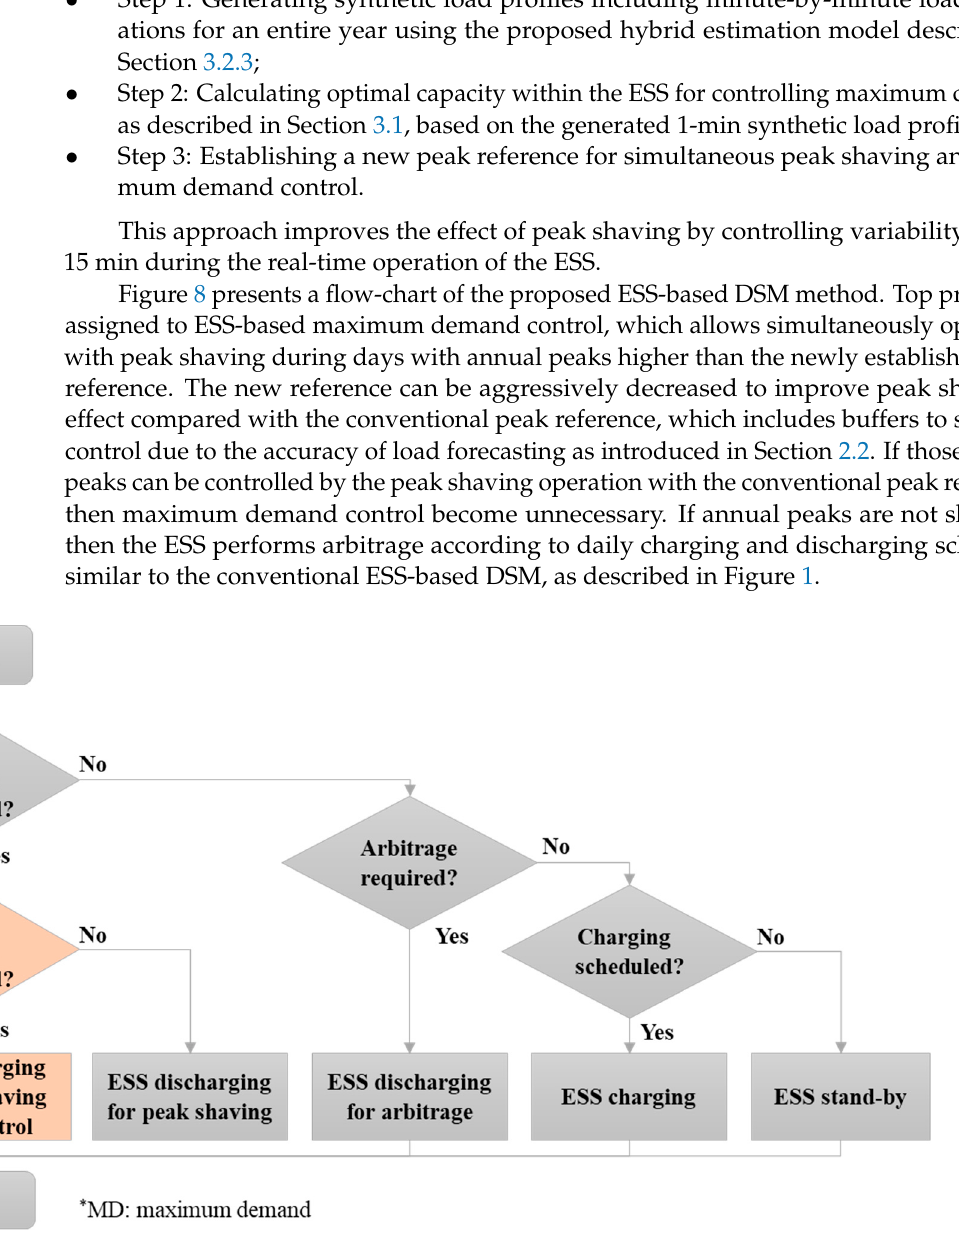
Figure 8. Flowchart of the proposed ESS-based DSM algorithm.